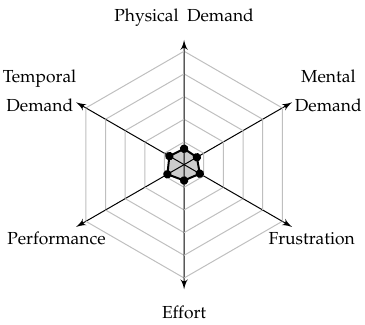
Figure 9. The Raw NASA Task Load Index (RTLX) measures the workload needed to operate the system. Our prototype requires a low averaged raw workload index of 3 (out of